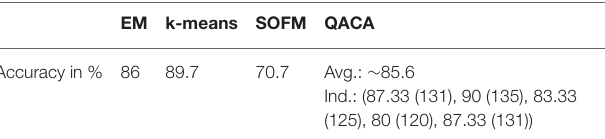
TABLE 1 | Algorithm comparison. TABLE 2 | Probabilistic